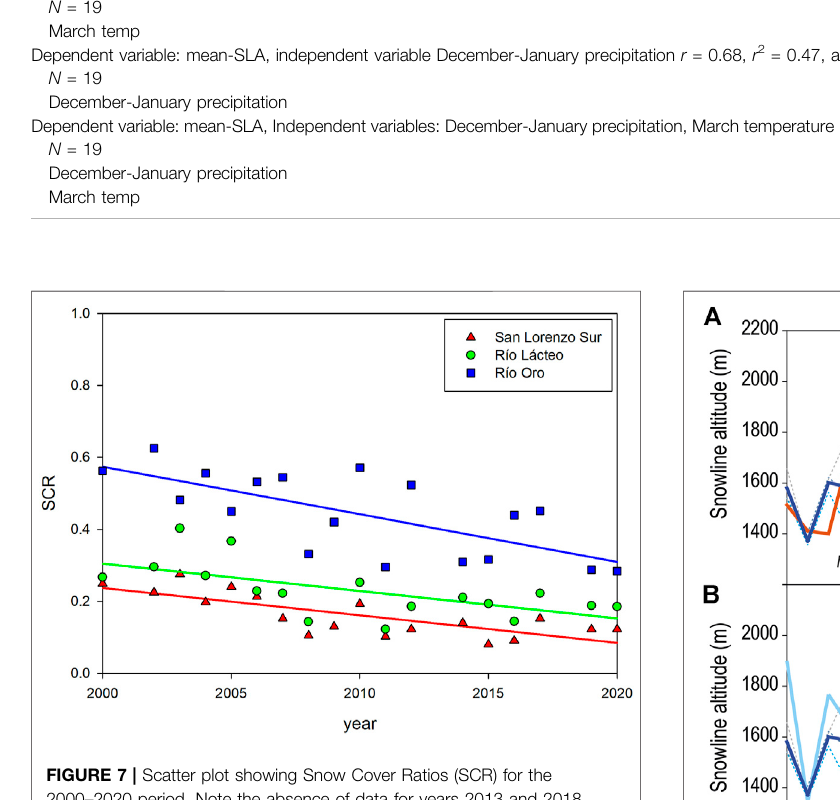
TABLE 3 | Regression summaries for mean snowline altitudes (mean-SLA) using March temperature, December-January precipitation, and both variables as predictors. Dependent variable: mean-SLA, independent variable Mar temp. r (cid:2) 0.64, r 2 (cid:2) 0.41, adjusted r 2 (cid:2) 0.37, F(1,17) (cid:2) 11.72 N (cid:2) 19